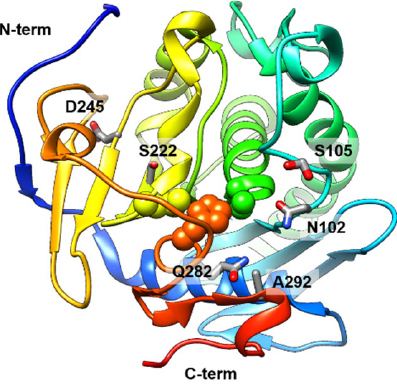
Figure 1. Selected hotspots in SMG1 for stability enhancement. Hotspot residues are shown as sticks in the SMG1 structure (PDB code 3UUE). The spheres represent the catalytic triad. The protein is in rainbow colors.